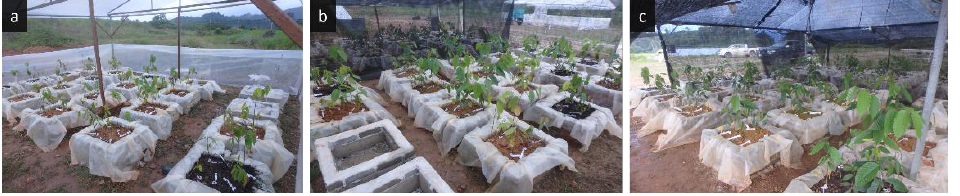
Figure 2. Shorea leprosula Miq. and Shorea acuminata Dyer tree seedlings in three levels of light irradiance; ( a ) 100% (control); ( b ) 30%; and ( c ) 8%.